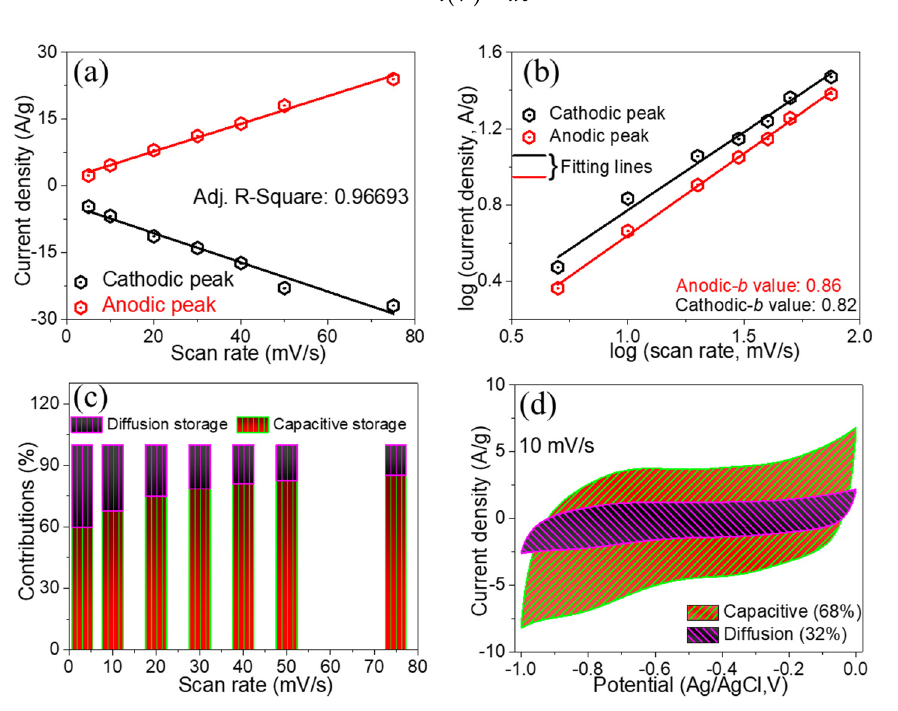
Figure 6. ( a ) Current density as a function of scan rate; ( b ) log (current density) vs. log (scan rate); ( c ) percentage contributions as a function of scan rate; ( d ) CV curve with percentage capacitive and diffusion charge storage at scan rate of 10 mV/s.